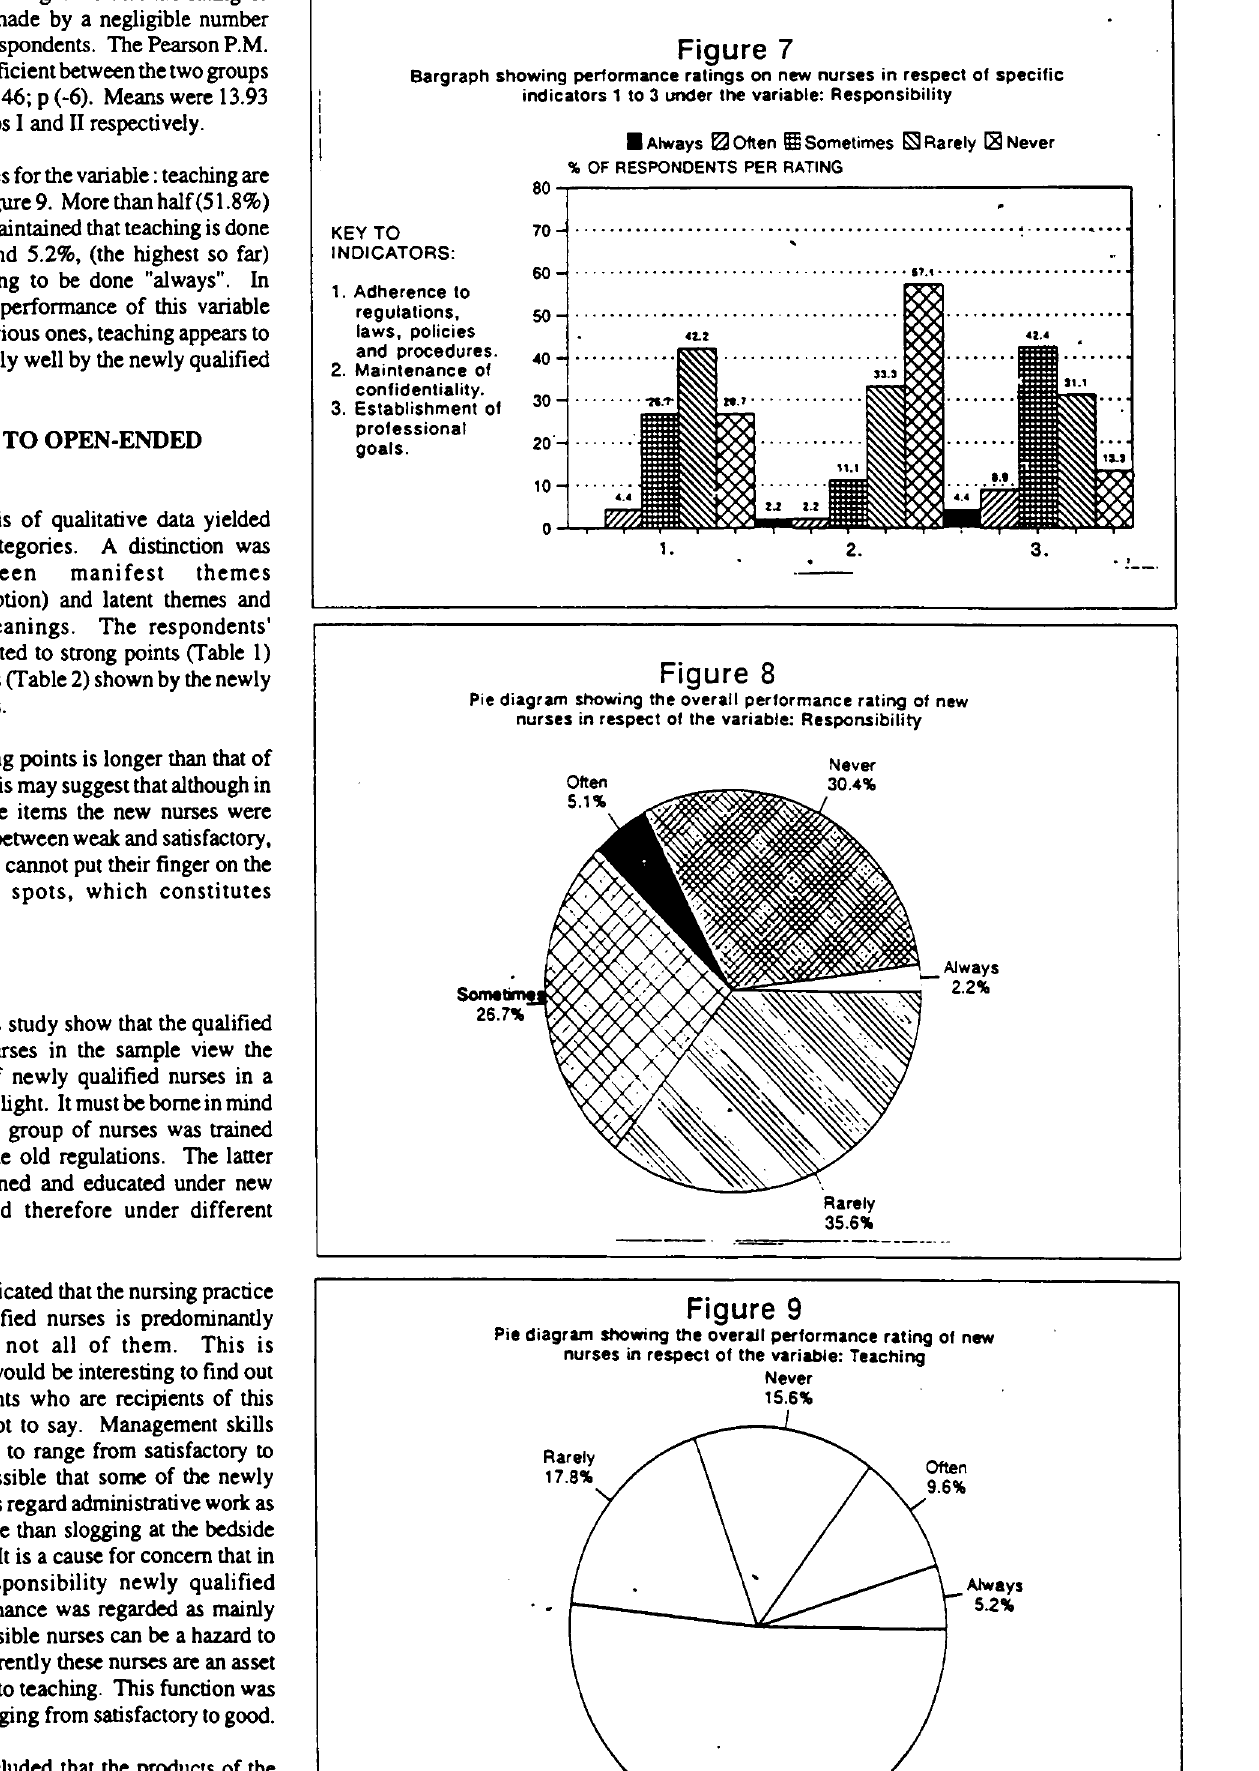
Bargraph showing peiiormance ratings on new nurses in respect of specific indicators 1 to 3 under the variable: Responsibility